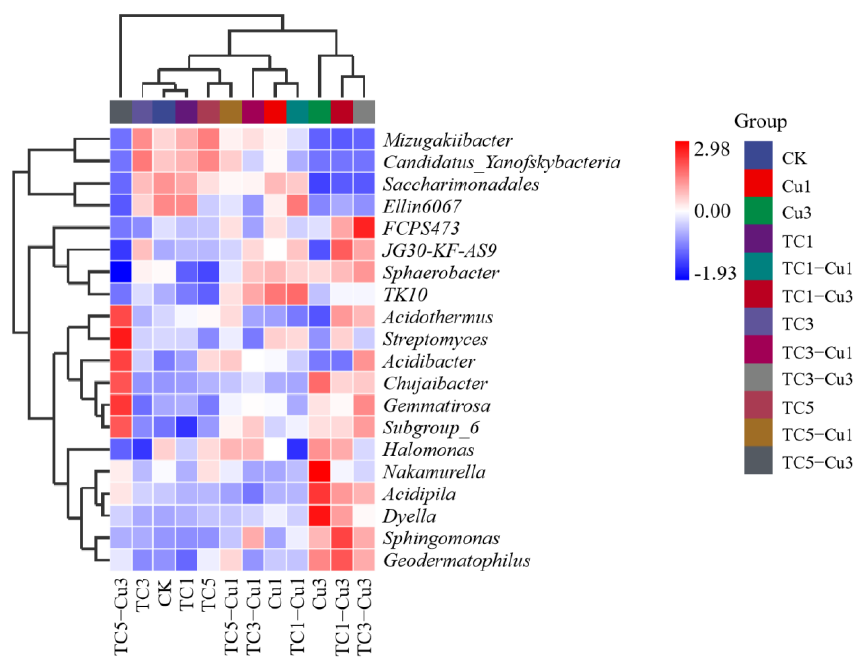
Figure 6. Clustering heat map analysis of the correlation between microbial community (genus) and treatments.